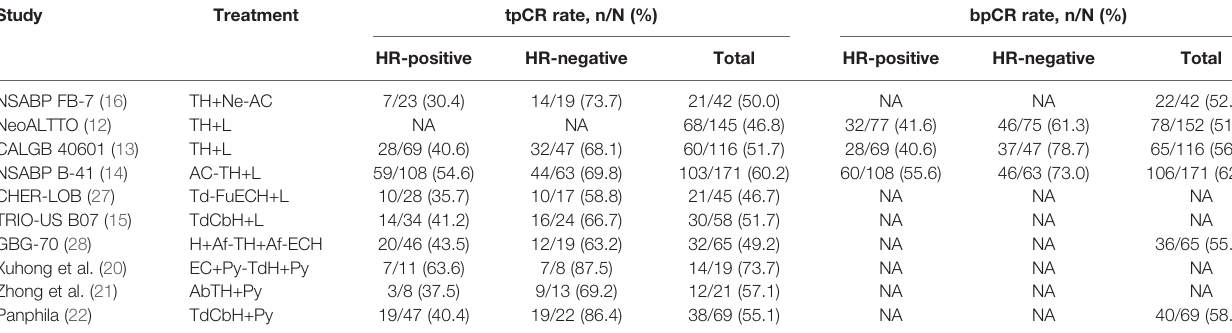
TABLE 5 | Pathological response results from current published neoadjuvant trials of tyrosine kinase inhibitor in HER2-positive breast cancer. Study